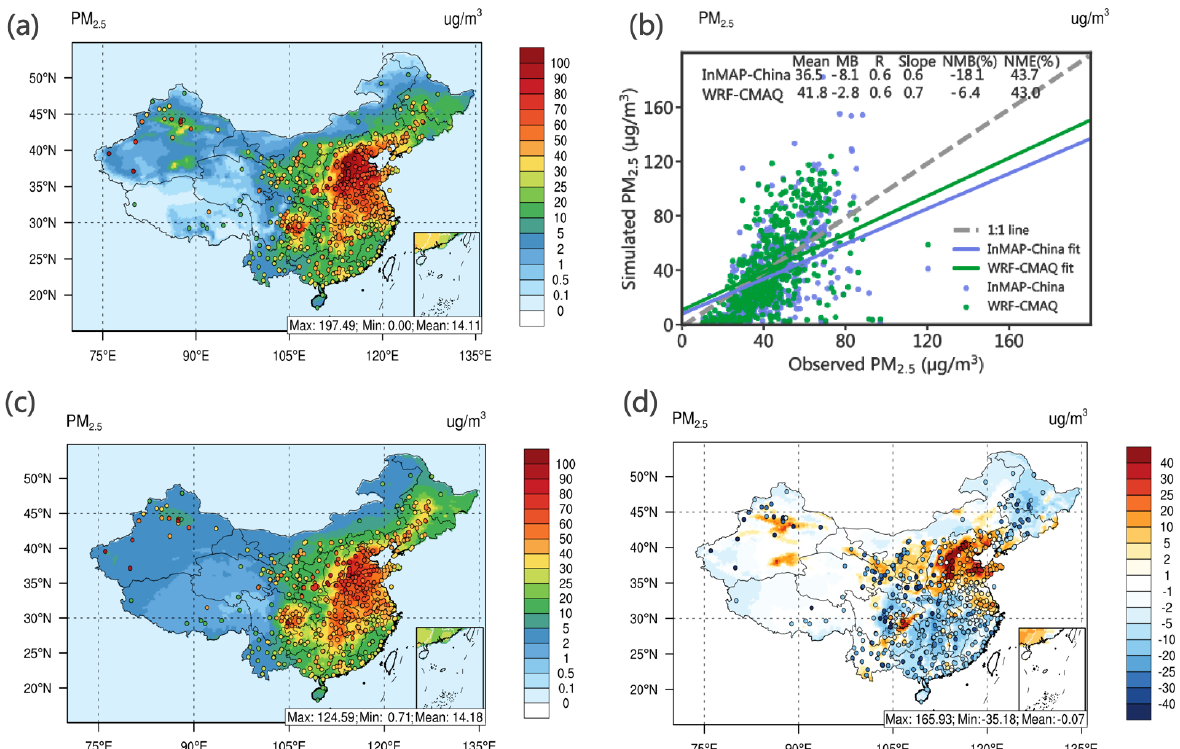
Figure 3. The spatial pattern and statistical metrics of total PM 2 . 5 concentrations predicted by InMAP-China and WRF-CMAQ. Panels (a) and (c) display the spatial patterns of total PM 2 . 5 concentrations predicted by InMAP-China and WRF-CMAQ, respectively. Panel (d) presents the difference in the spatial distribution of the total PM 2 . 5 concentrations predicted by the two models. Panel (b) shows the statistical metrics between the simulated and observed PM 2 . 5 . The observed total PM 2 . 5 concentrations are marked as circles in panels (a) and (c) . In panel (d) , the circle shows the difference between the PM 2 . 5 simulated by InMAP-China and the observed PM 2 . 5 . The same color bar is utilized for the contours and the marked